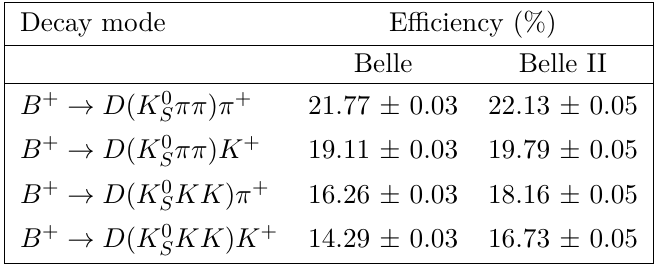
(cid:0) (cid:1) K 0 h + h − h + signal efficiencies estimated from simulated non-resonant signal S